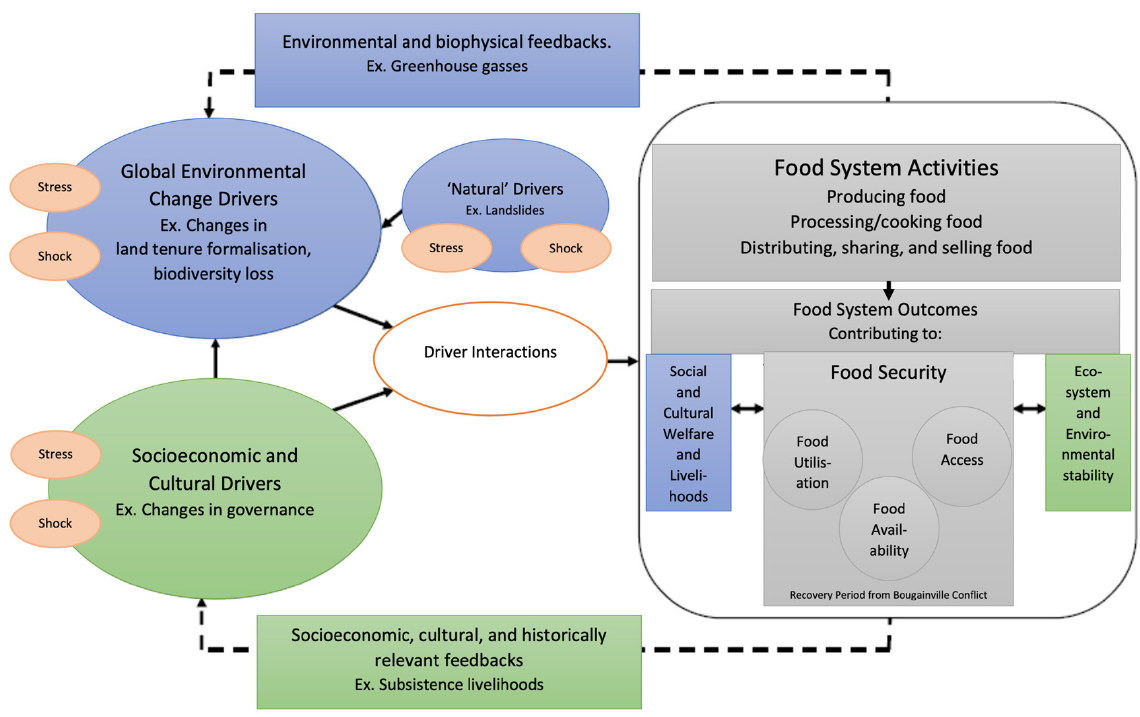
Figure 2. Figure adapted from Ericksen (2008) and applied to a Bougainvillean context. It represents the interconnections and feedbacks of the food system as a whole, addressing all components of the food system (and what is considered “within its boundaries”) along the supply chain (food system activities) and with reference to sociocultural and global environmental change drivers, shocks, and stresses, not only the biophysical as with the prevailing classical development paradigms [4].